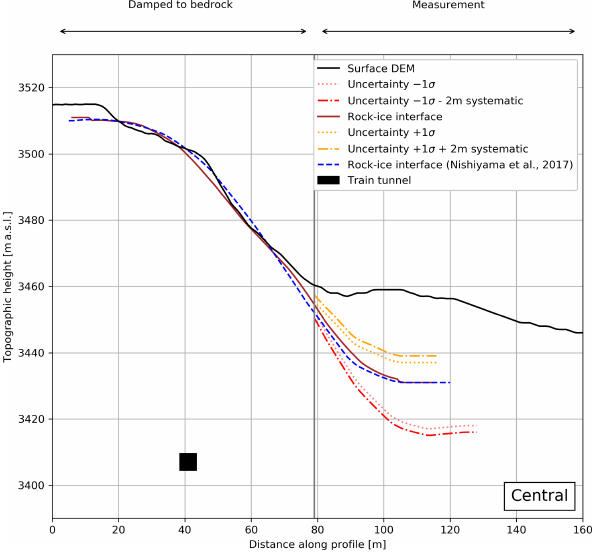
Figure 7. Central cross section. The brown and dashed blue lines indicate the ice–bedrock interface solutions of this study and the one from Nishiyama et al. (2017), respectively. The 1 σ error margins are shown in yellow (upper) and red (lower). The dotted margins encompass only the statistical variation of the interface position, whereas the dash-dotted margins include a ± 2m systematic error, which stems from the inherent DEM uncertainty. For completeness, we also show the position of the railway tunnel as a black square.